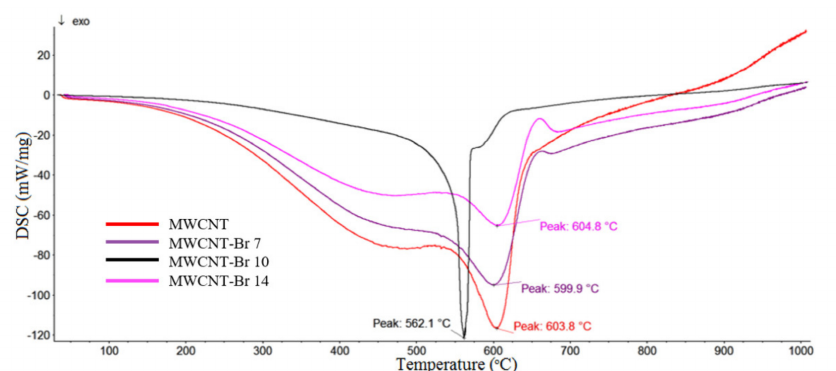
Figure 9. DSC curves for native and brominated MWCNTs.